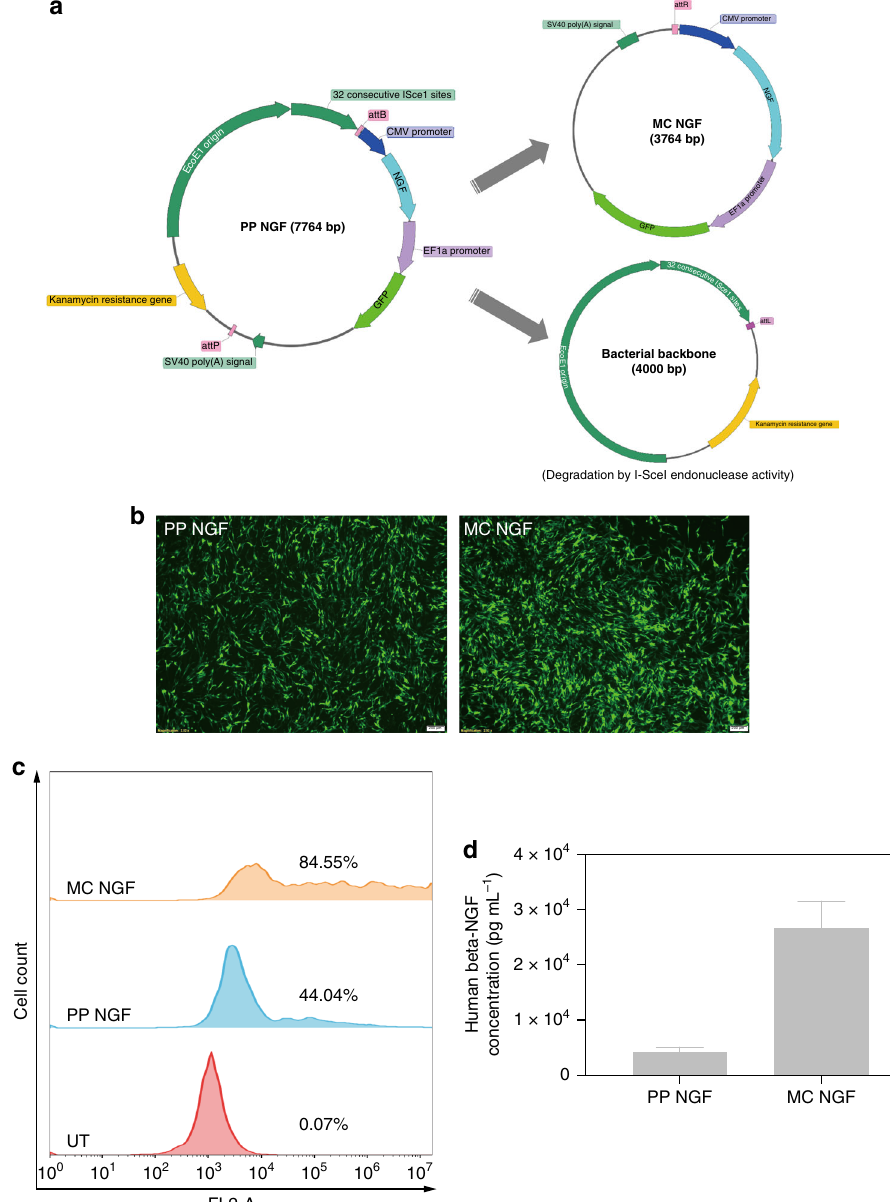
Fig. 9 Construction of NGF encoding plasmids and evaluation of transfection ef fi cacy. a Production of MC NGF in ZYCY10P3S2T E. coli . MC are produced from Parental plasmid using PhiC31 Integrase system. b GFP expression of Neu7 after transfection with HPAESG-1/PP NGF and HPAESG-1/MC NGF at the w / w = 20:1. The scale bars represent 200 μ m. c Representative histogram distributions of UT Neu7 and the ones after transfection with HPAESG-1/PP NGF and HPAESG-1/MC NGF at the w / w = 20:1. d Human beta-NGF concentration of supernatants from Neu7 astrocytes after transfection with